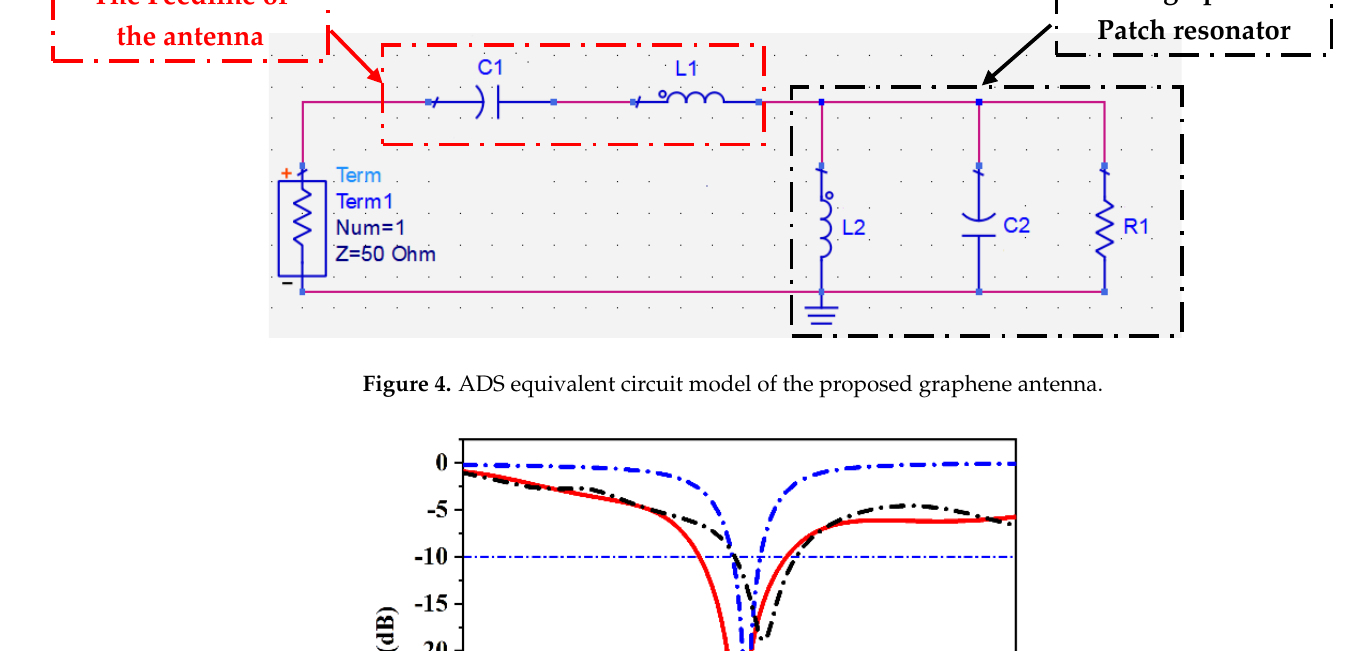
Figure 5. |S 11 | of the single element graphene plasmonic patch antenna with different simulation programs .